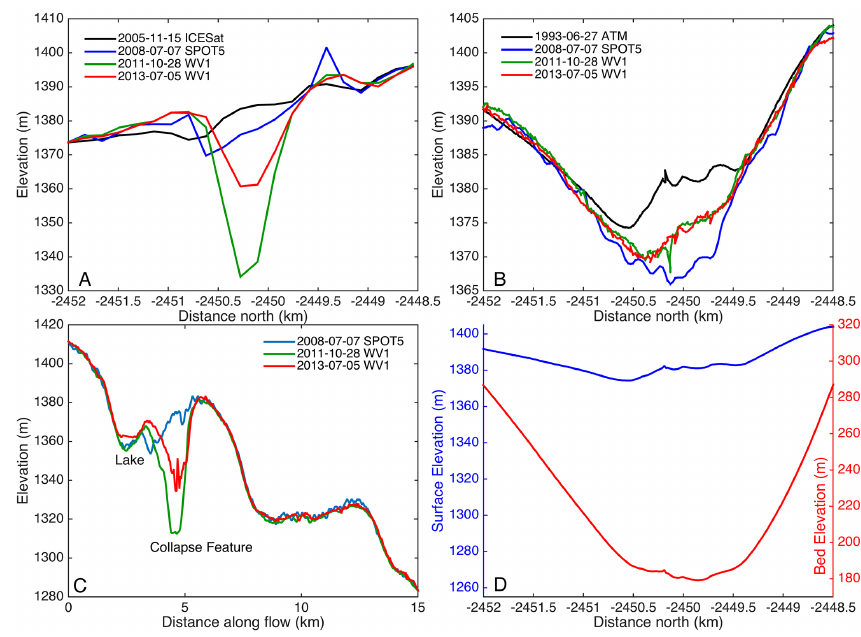
Figure 3. Surface elevations from laser altimetry and stereoscopic digital elevation models along the (a) 15 November 2005 ICESat-1 and (b) 26 June 1993 ATM tracks shown in Fig. 2. (c) Along-flow (east to west) surface elevation profiles through the center of the depression from three stereoscopic DEMs. (d) Surface (blue) and bed heights (red) for the 1993 airborne survey over the eastern portion of the depression (see Fig. 2). Both vertical axes have the same